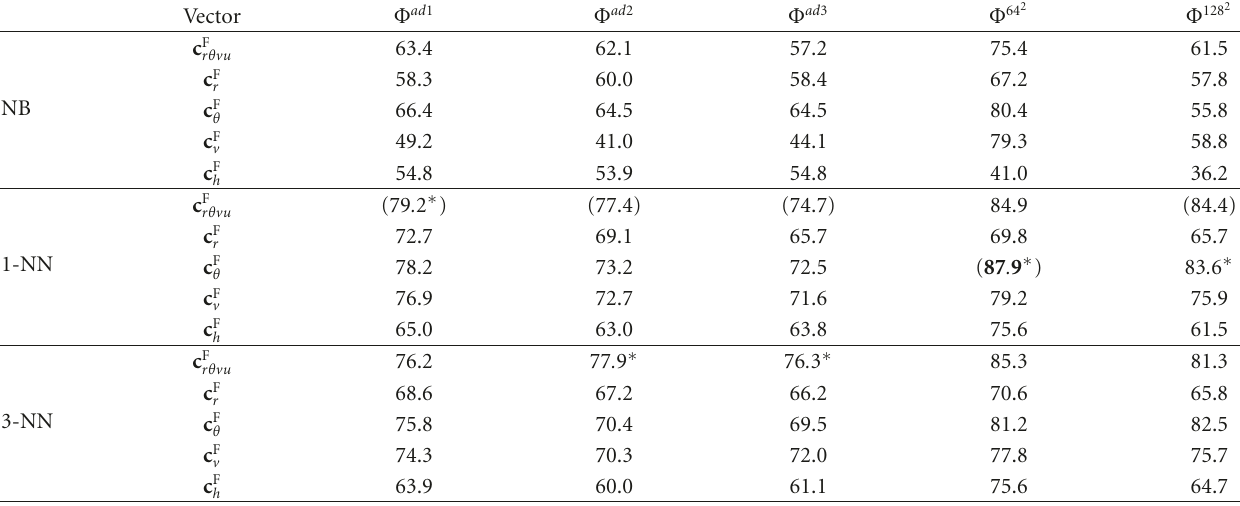
Table 6: Rate C P of correctly classified patterns for five image sets with Fourier’s textural features. The best rates C P for each image set are shown by an ∗ . The best rates C P for each image set and for a 1-NN classifier are depicted in brackets.